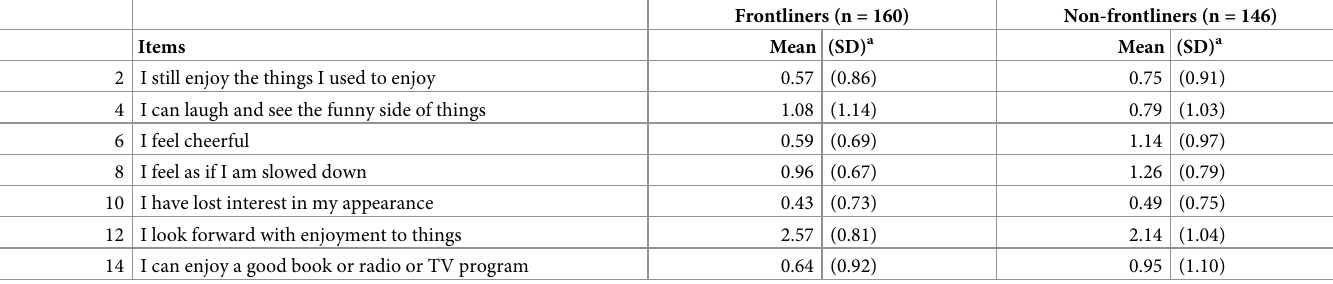
Table 2. Hospital Anxiety and Depression Scale-Depression items among healthcare providers.